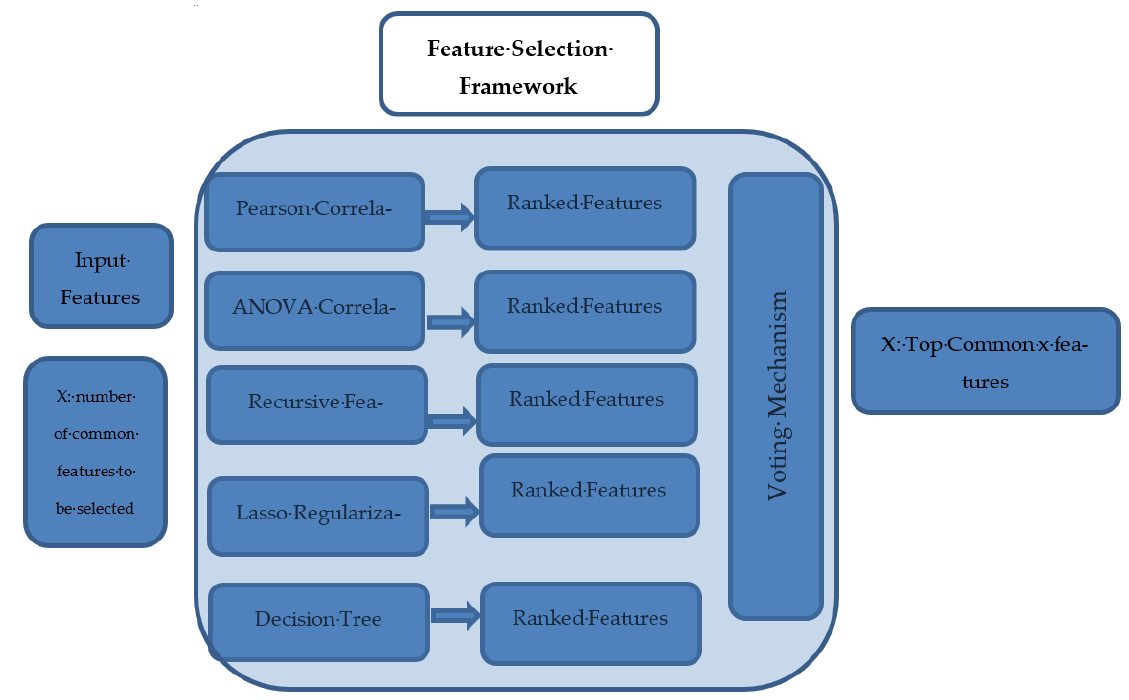
Figure 1. Feature selection framework.